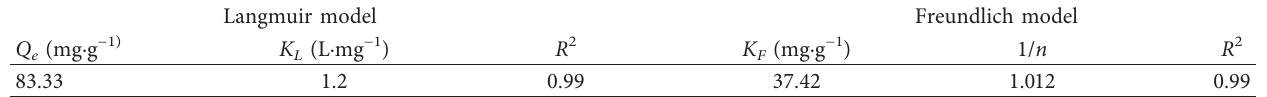
Figure 12: Adsorption isotherm of phenol on Sale clay, Freundlich model. Table 6: Parameters deduced from the Langmuir and Freundlich lines.